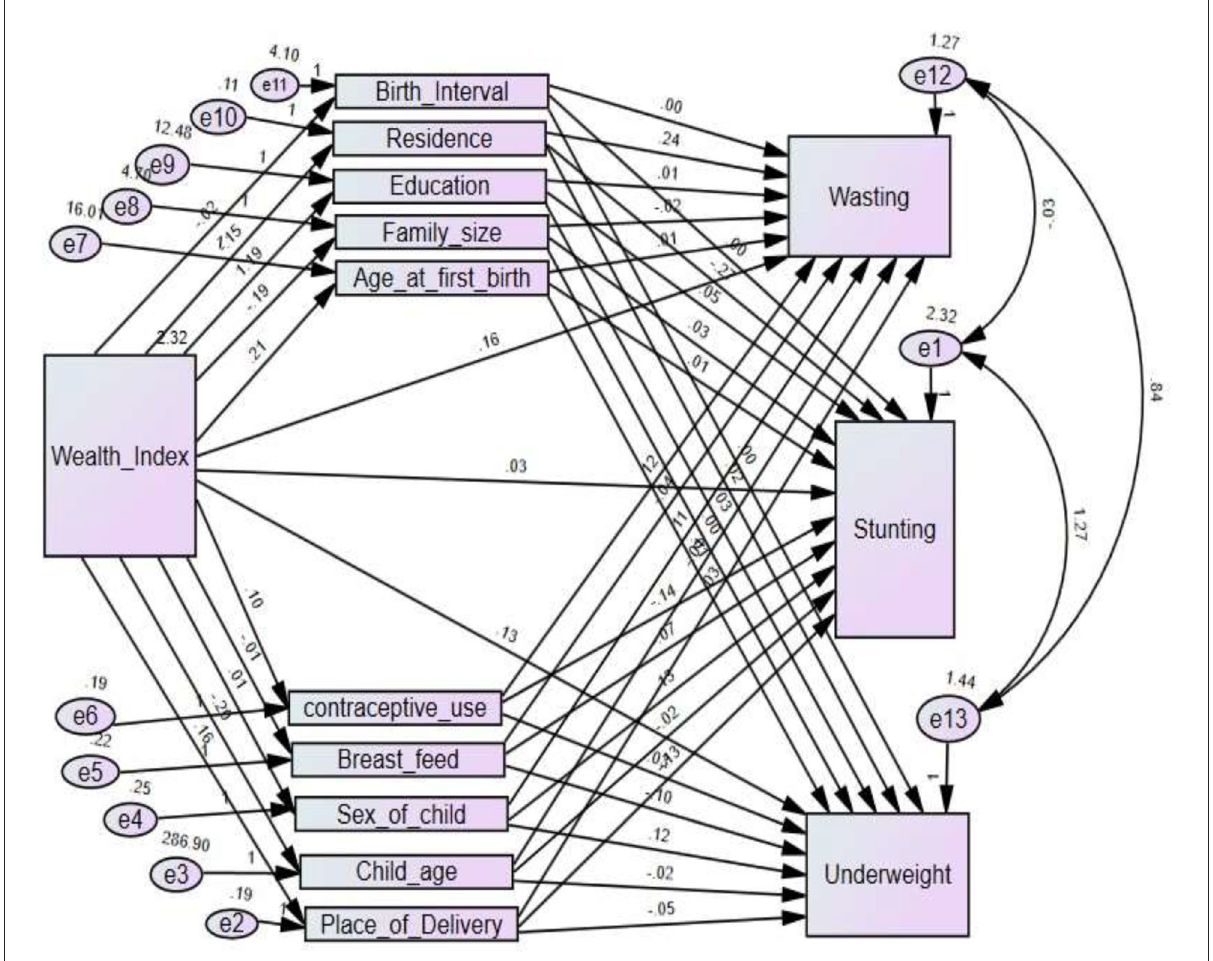
FIGURE6 Path diagram of mediators of the link wealth index and the anthropometric indices (underweight, stunting, and